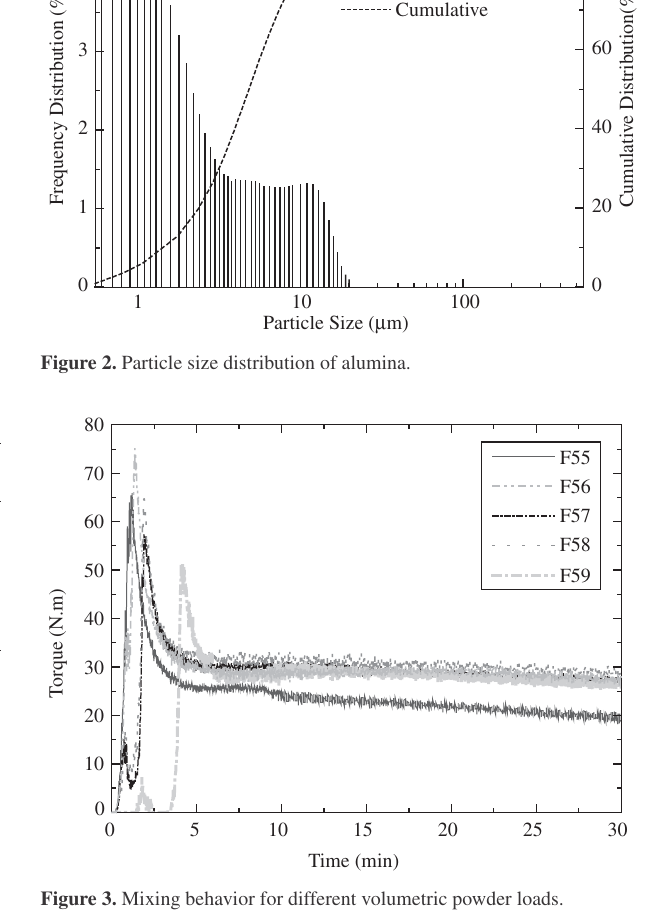
Figure 3. Mixing behavior for different volumetric powder loads.